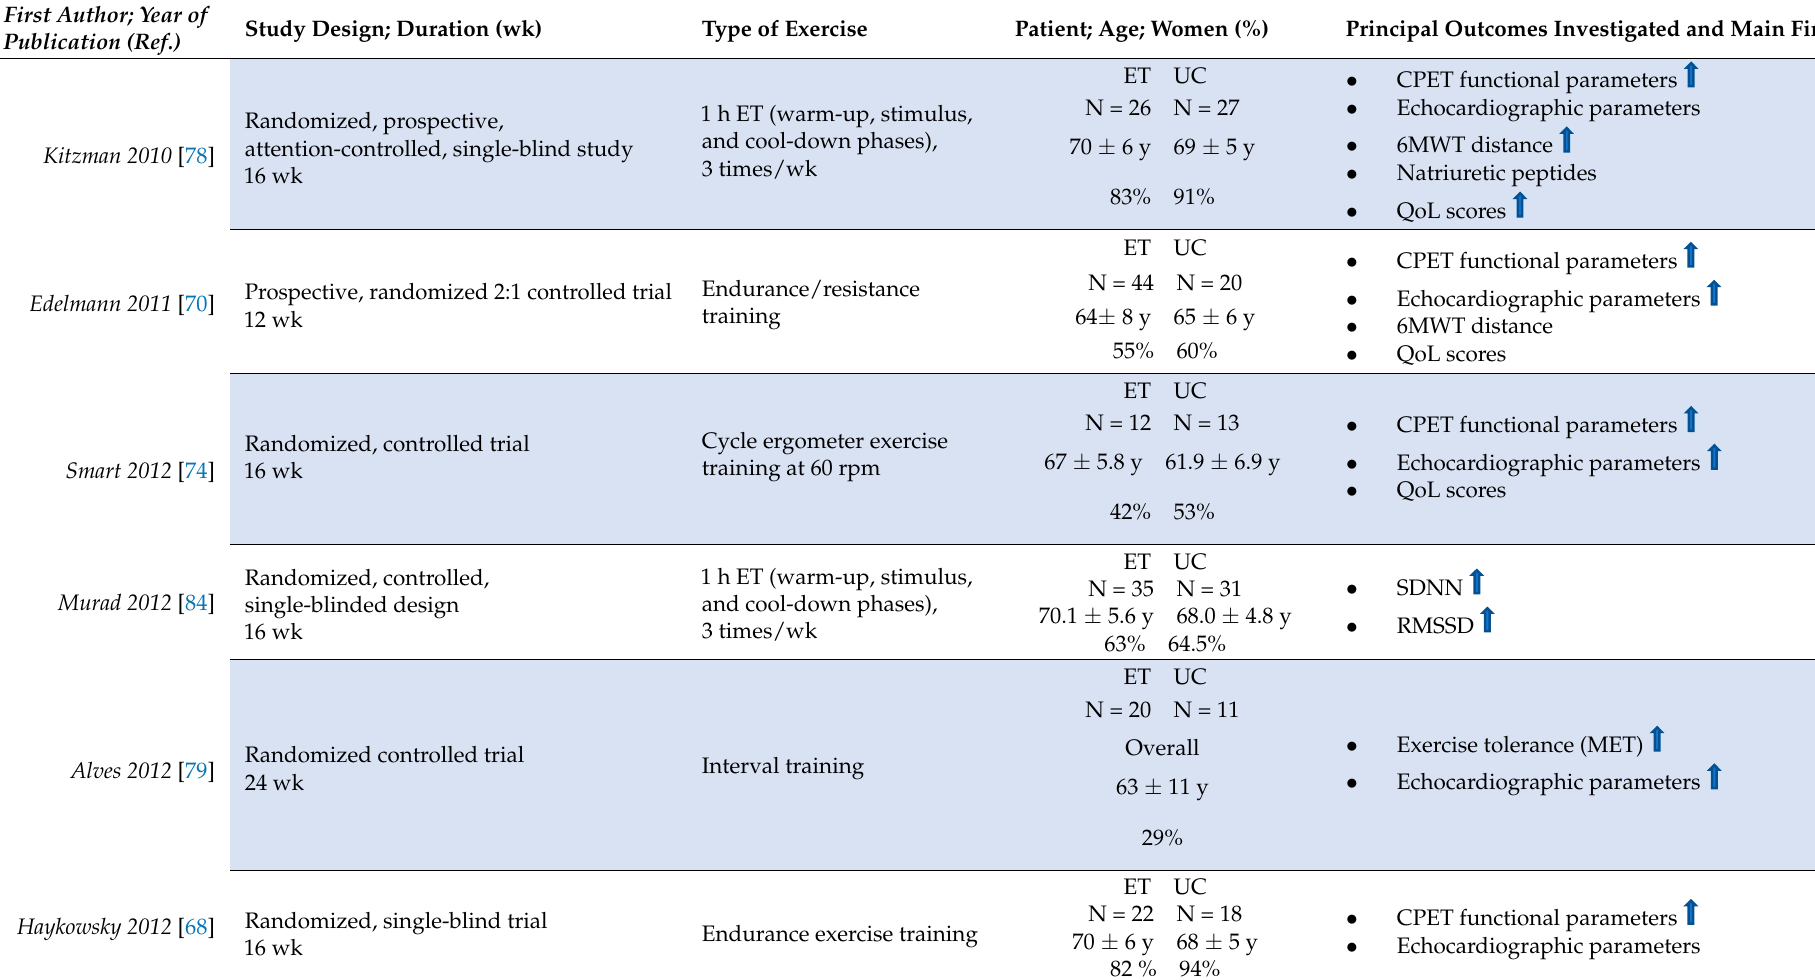
Table 7. List of studies investigating the role of exercise training in patients with preserved ejection fraction.